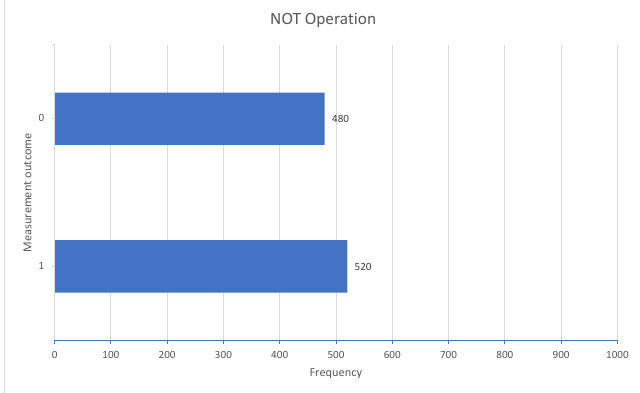
Figure 2. Quantum circuit for the NOT operation. After the measurement, we have close to 50% of bits 0 and close to 50% of bits 1, which is what we expected. Figure 3 shows the outputs obtained after running the program 1000 times in the IBM quantum simulator [32].